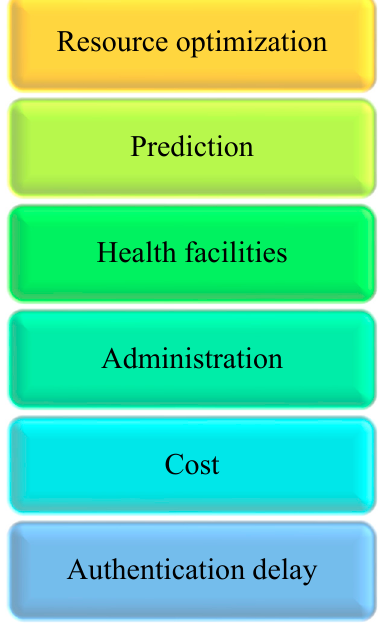
Figure 1. Selected Features.